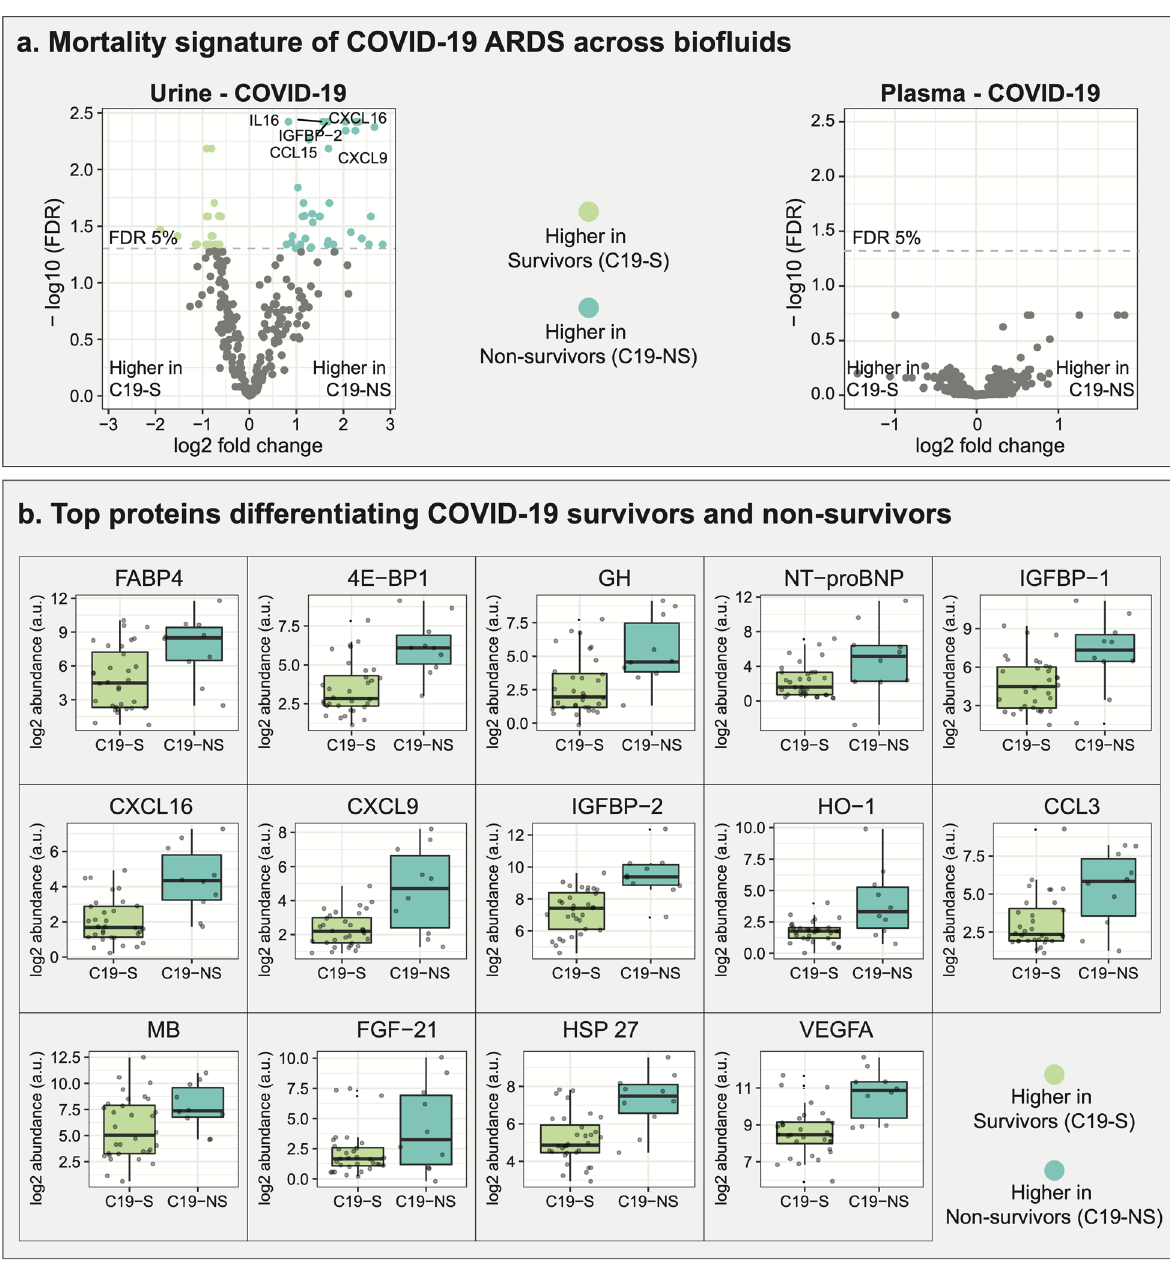
Fig. 3 Proteomics‑based mortality signature. a Differentially abundant proteins in COVID‑19 survivors and non‑survivors, as observed in two bodily fluids, urine ( n 42) and plasma ( n 43, one additional patient). 60 proteins were significant in urine proteomic profiles, while none of the proteins = = measured in the plasma of the same patients were associated with mortality. b Top 14 differential proteins from COVID‑19 urine‑based mortality signature with log2 fold change larger than or equal to 2 at 5%